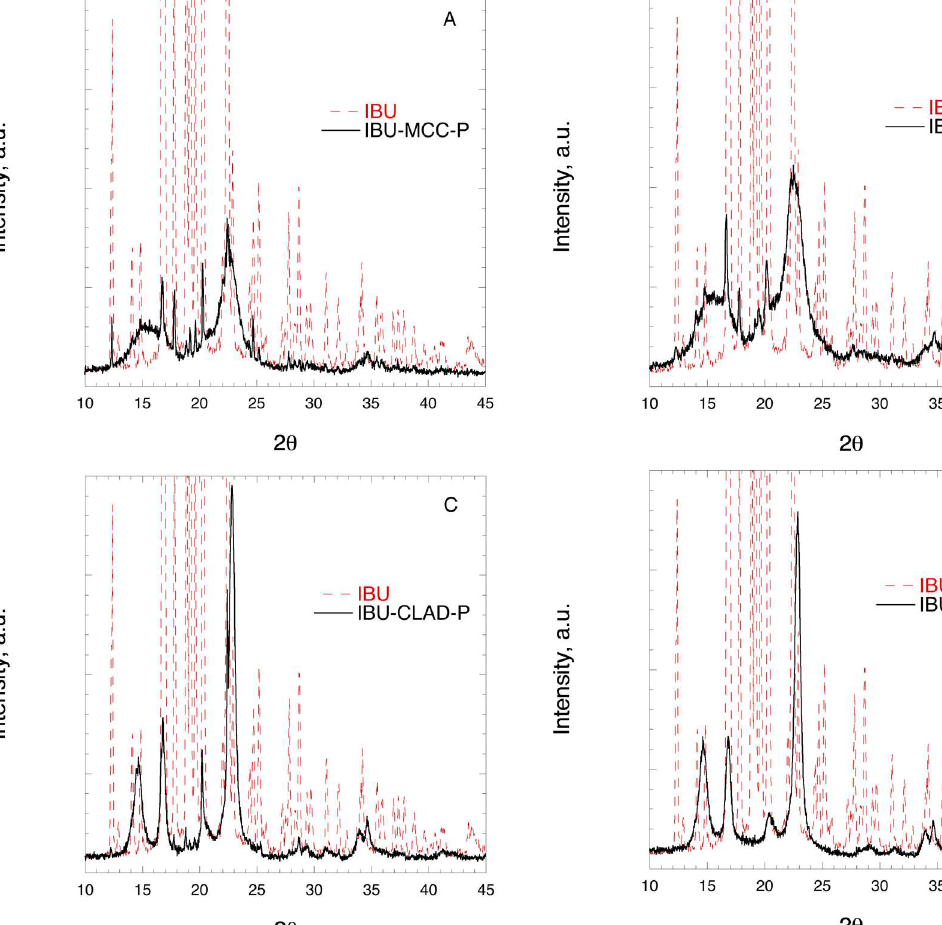
Figure 4. X-ray diffraction images of ( A ) IBU-MCC-P, ( B ) IBU-MCC-H, ( C ) IBU-CLAD-P, and ( D ) IBU-CLAD-H 10% w / w mixtures.